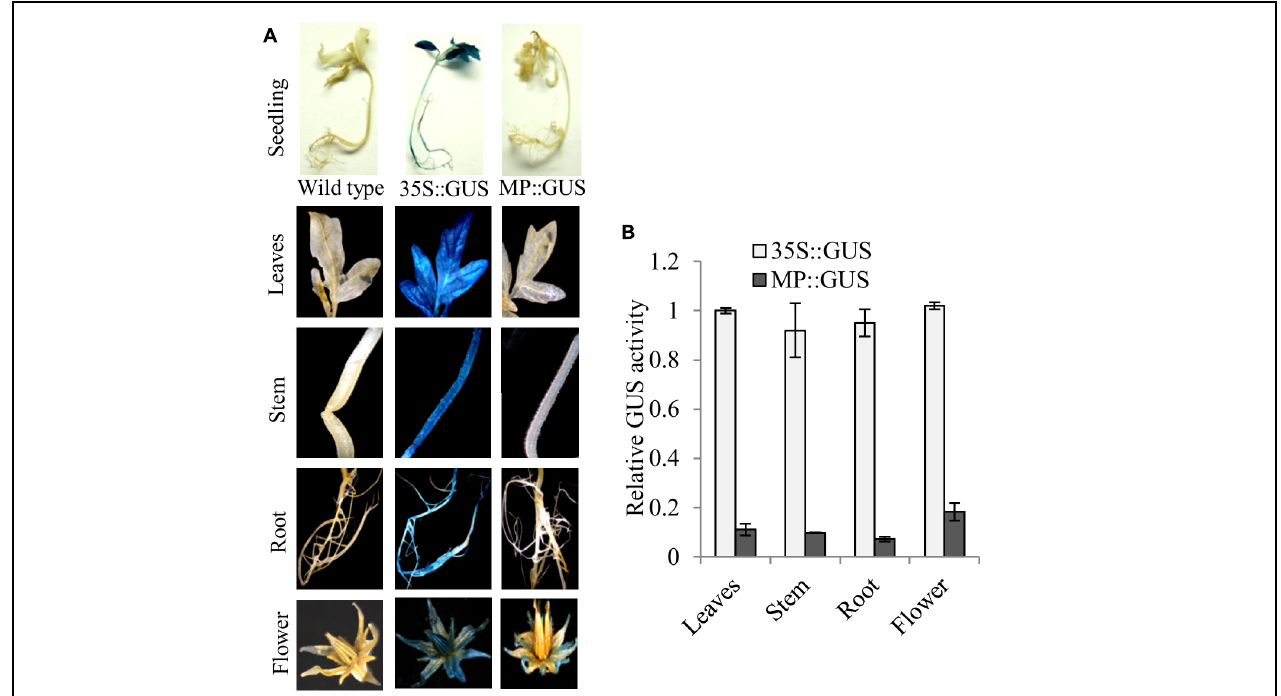
FIGURE 3 | Histochemical and fluorometric assays to detect GUS activity in different plant parts. (A) Seedling, leaves, stem, root, and flower from MP::GUS, 35S::GUS and wild type (untransformed) were subjected to histochemical staining. (B) Fluorometric analysis of GUS activity. Data are presented as the mean ( ± SE) of three biological